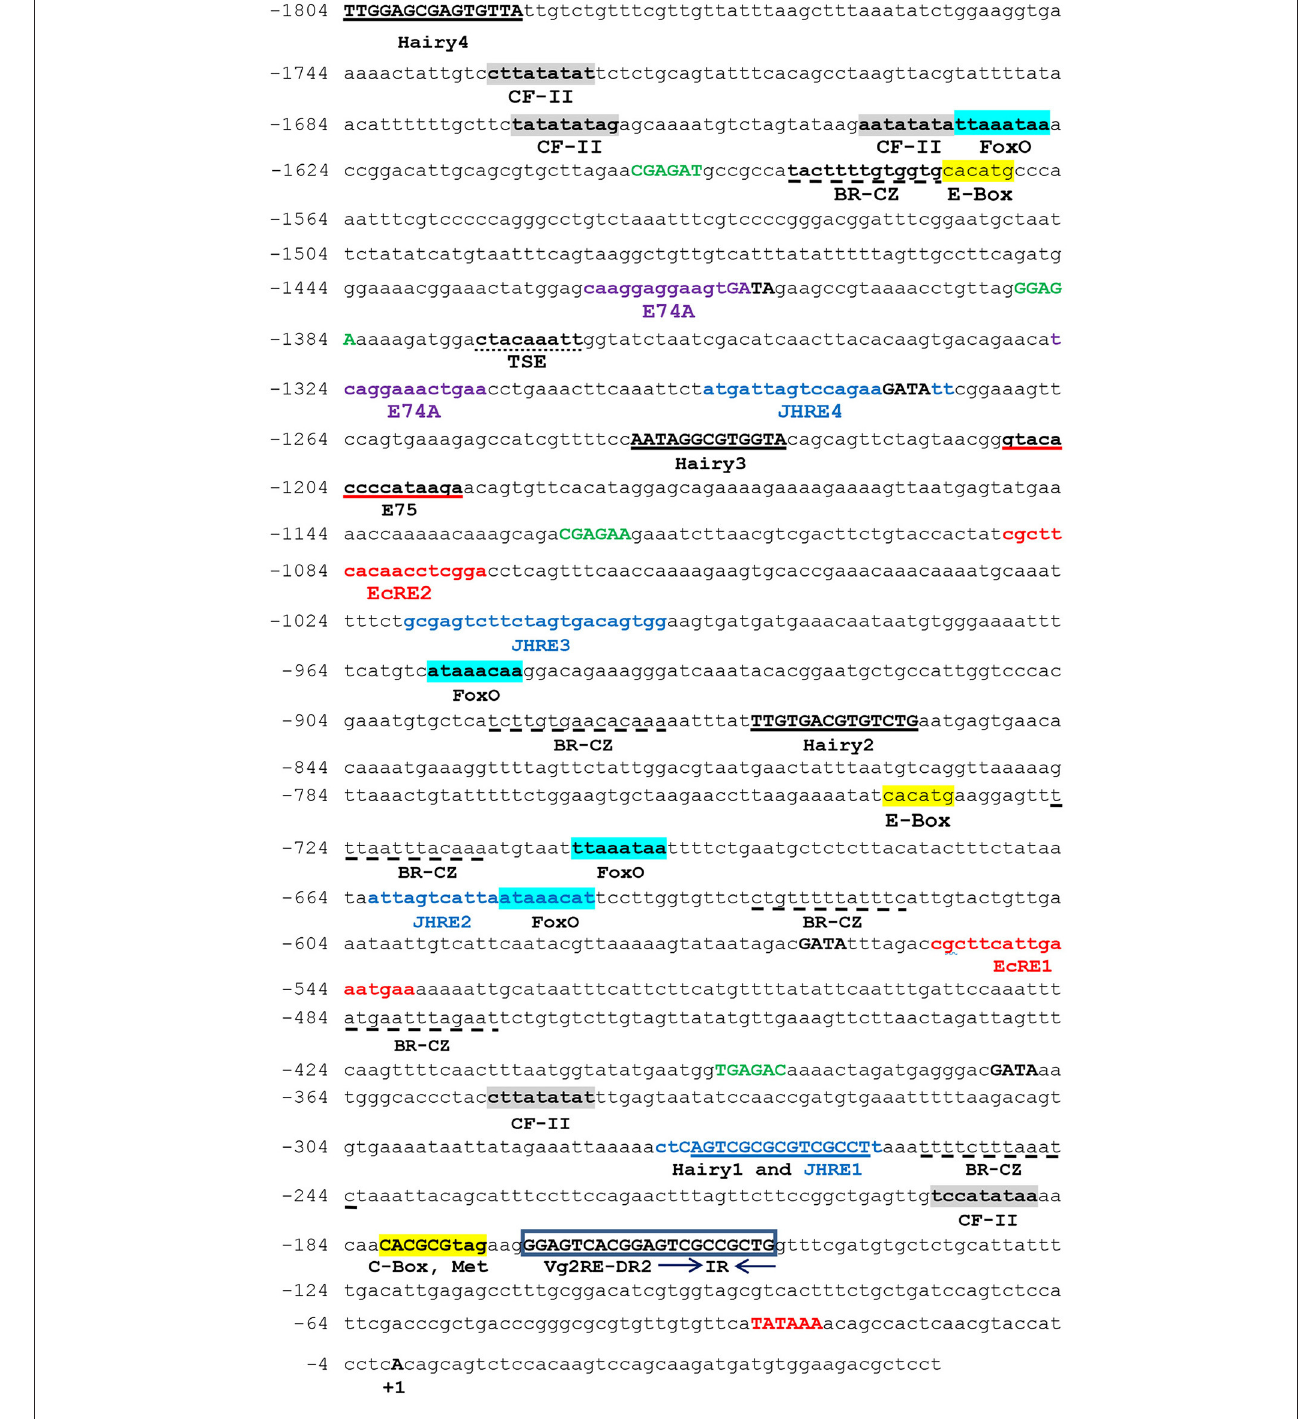
FIGURE 1 | Nucleotide sequence of the Vitellogenin 2 ( Vg2 ) promoter. The nucleotides are numbered from the transcription start point as + 1. The name of the binding factor is written under its consensus sequence. TATA box, GAGA, and GATA elements are shown in bold red, bold green, and bold black capital letters, respectively. Juvenile hormone response element (JHRE): blue color. Ecdysone response element (EcRE): red color. Broad complex (Br-CZ) dashed underline. Chorion factor (CF-II): gray box. Hairy is underlined. E-Box and C-Box: yellow box. E74A: violet color. E75: red underline. FoxO: blue box. Tissue-specific expression (TSE): dot underlined. The direct repeat Vg2 RE-DR2 is bold, inside frames. Arrows indicate the directions of the inverted repeats IR.